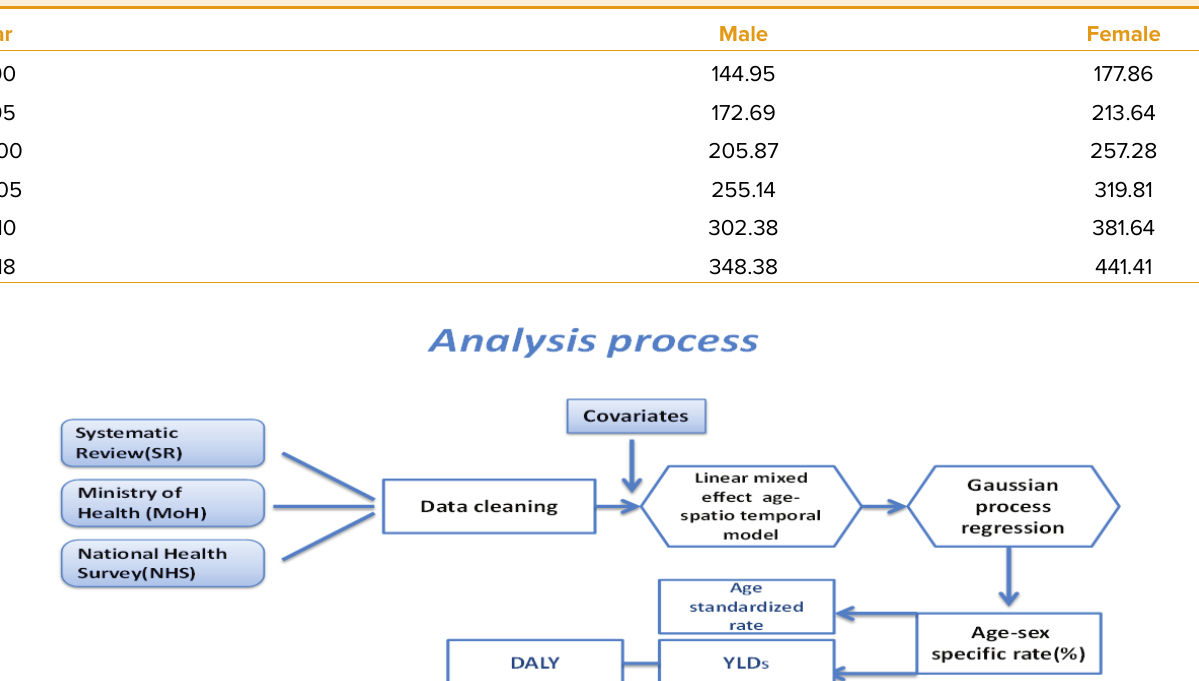
Table 3. Age-standardized DALYs per 100,000 in different years and sex.